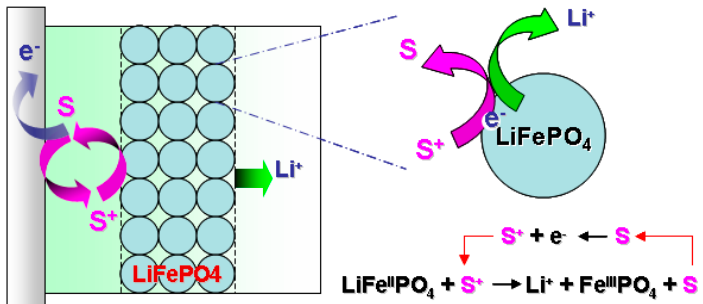
Figure 4. The principle of redox targeting of an insulating electrode material, such as LiFePO 4 , by a freely-diffusing molecular shuttle, S [115] (reprinted with permission from Angew Chem Int Ed Engl 45, 8197–8200, (2006); Copyright 2006, WILEY-VCH Verlag GmbH & Co. KGaA, Weinheim).